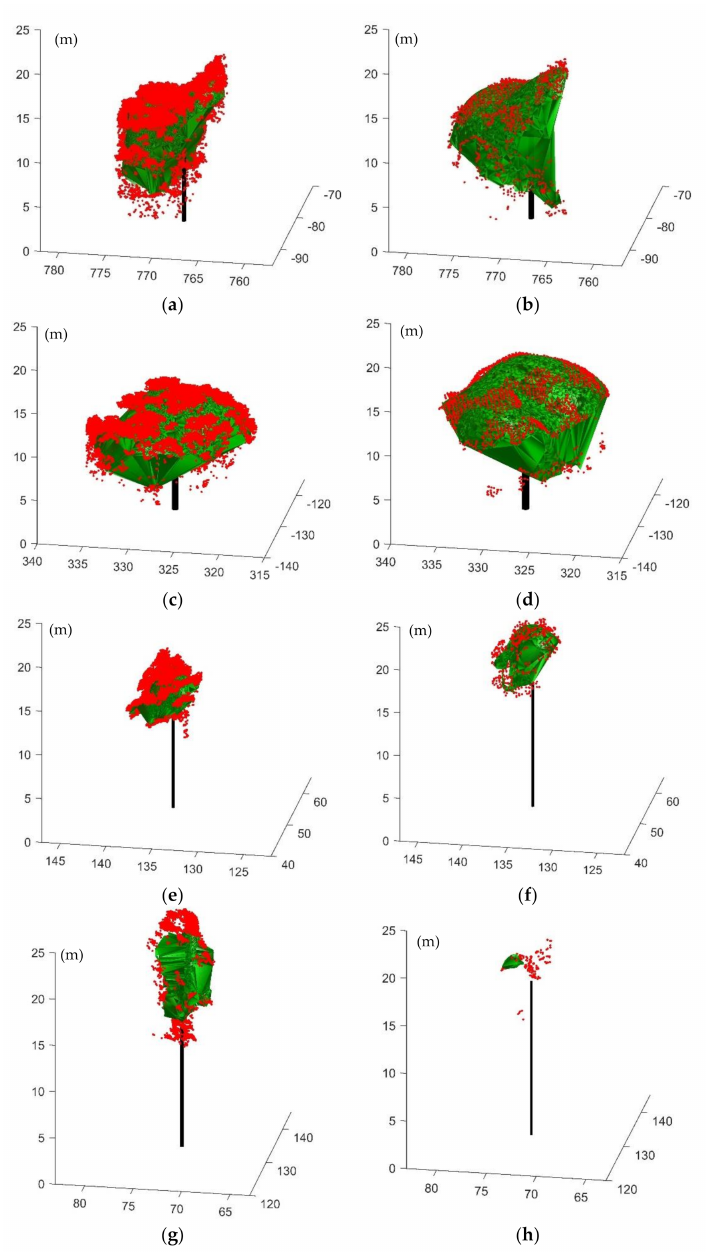
Figure 11. 3D models by the spherical harmonics fitting method of ( a ) the first tree sample using the LiDAR method, ( b ) the first tree sample using the photogrammetric method, ( c ) the second tree sample using the LiDAR method, ( d ) the second tree sample using the photogrammetric method, ( e ) the third tree sample using the LiDAR method, ( f ) the third tree sample using the photogrammetric method, ( g ) the fourth tree sample using the LiDAR method, and ( h ) the fourth tree sample using the photogrammetric